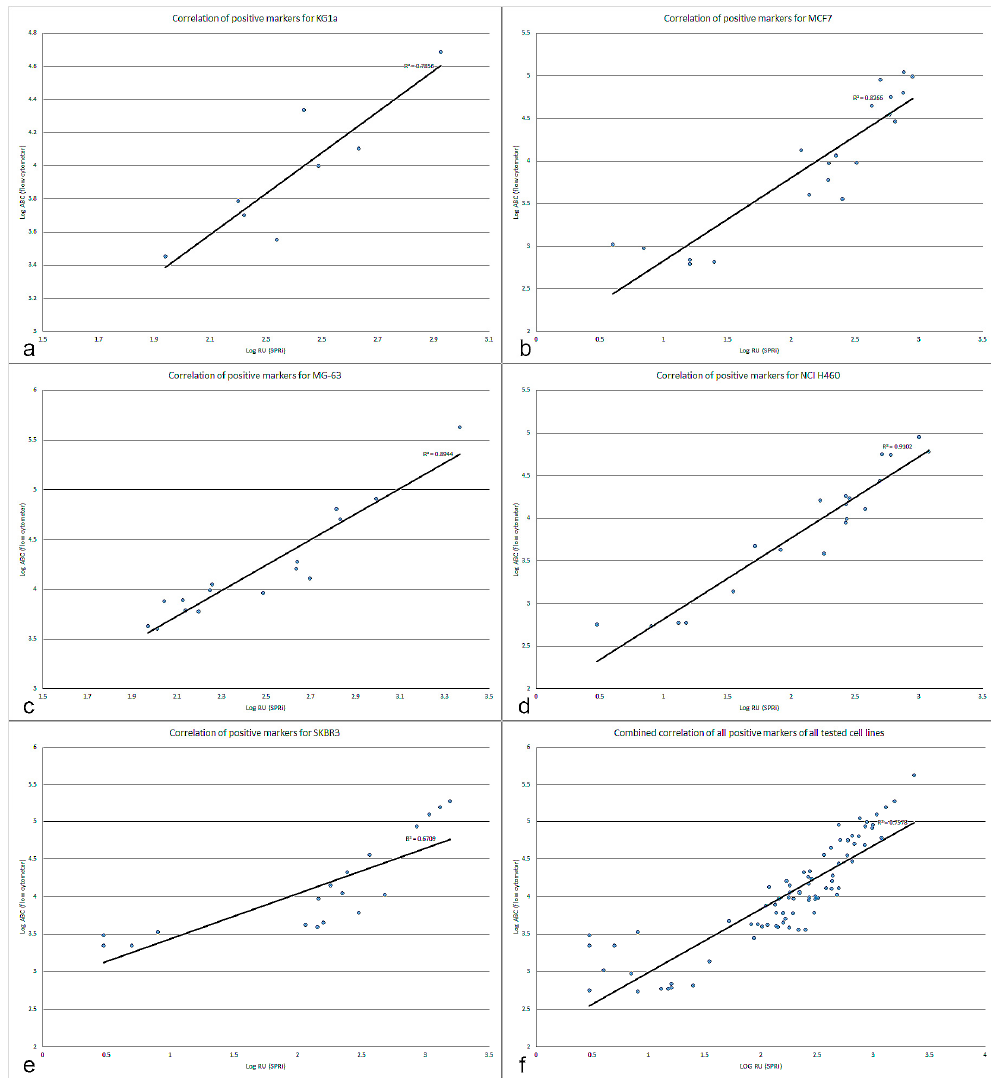
Figure 4. ( a ): Correlation plot of the positive markers for KG1a. ( b ): Correlation plot of the positive markers for MCF7. ( c ): Correlation plot of the positive markers for MG-63. ( d ): Correlation plot of the positive markers for NCI H460 (ATCC HTB-177™). ( e ): Correlation plot of the positive markers for SKBR3. ( f ): Combined correlation plot of all the positive markers of all the cell lines.